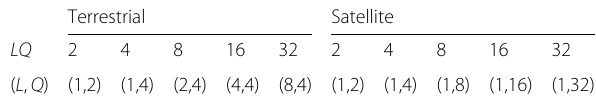
Table 1 Best ( L , Q ) for different LQ Terrestrial